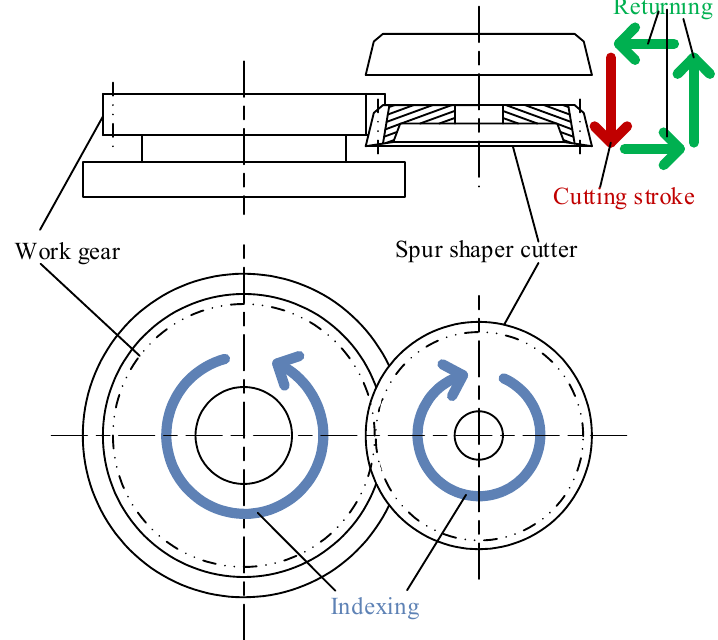
Figure 1. Motions of the gear shaping cycle.